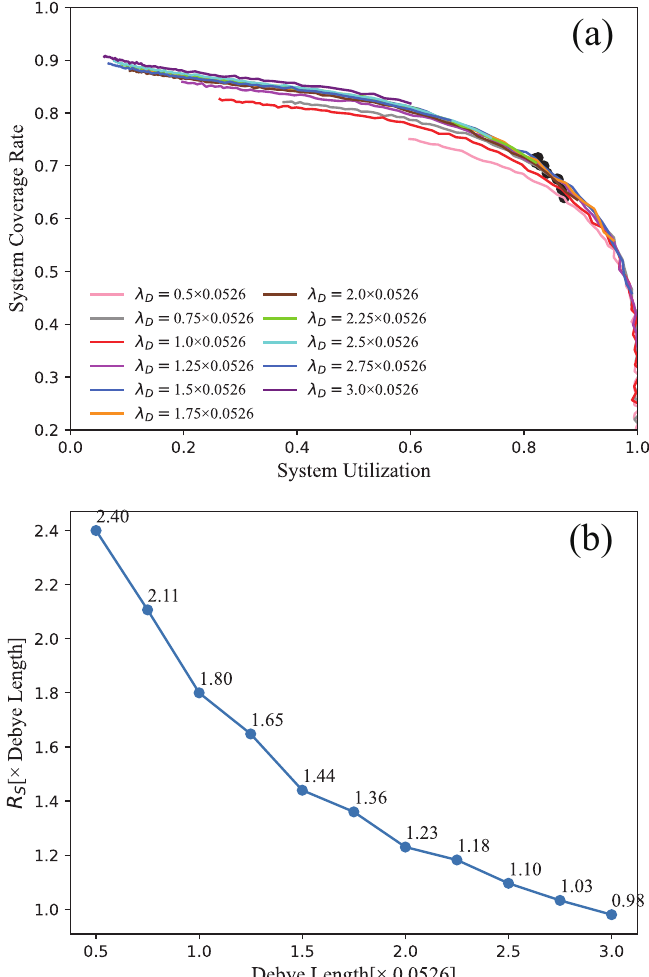
Figure 9. ( a ) The variation of coverage rate and the system utilization depending on different λ D . ( b ) optimal R S for different λ D